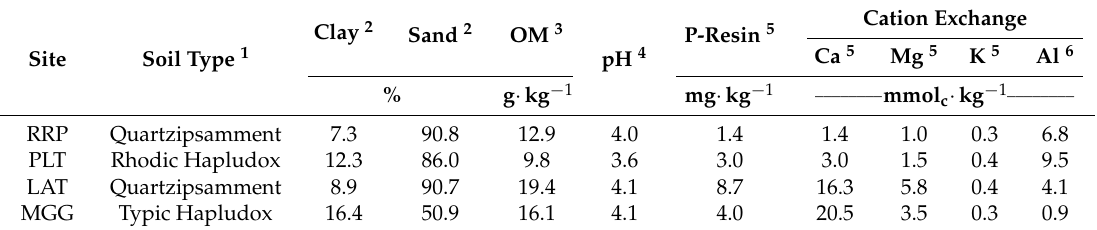
Figure 1. Location of the studied site in the states of São Paulo and Mato Grosso do Sul. Table 2. Soil classification, physical and chemical attributes (0–20 cm depth layer) at the studied sites.